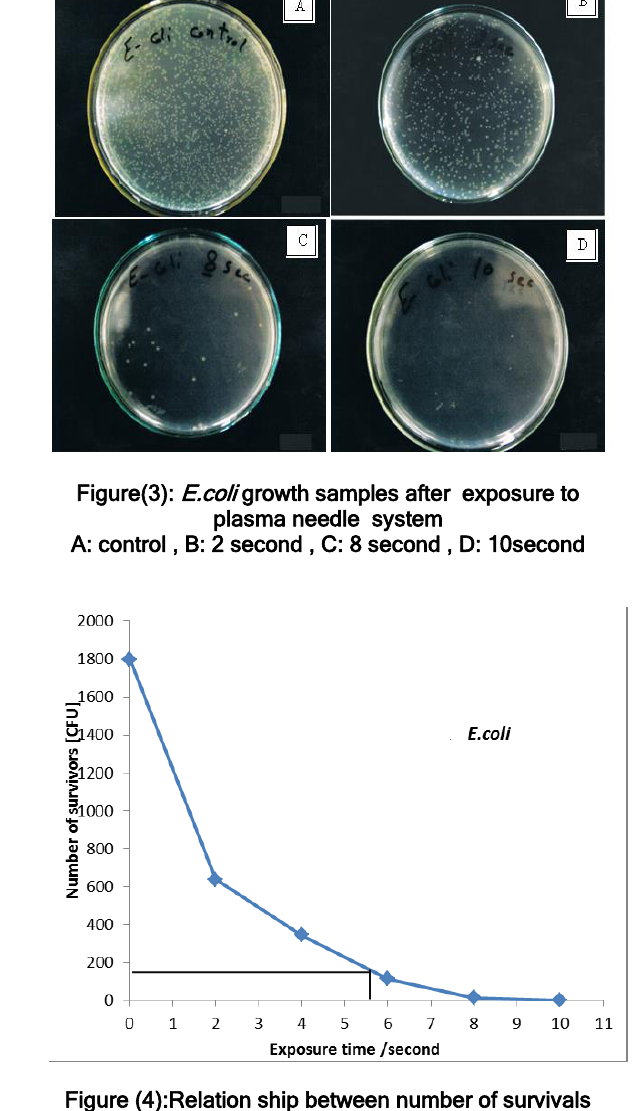
Figure (2): Sex distribution (female & male) for patterns those help in these experiments.